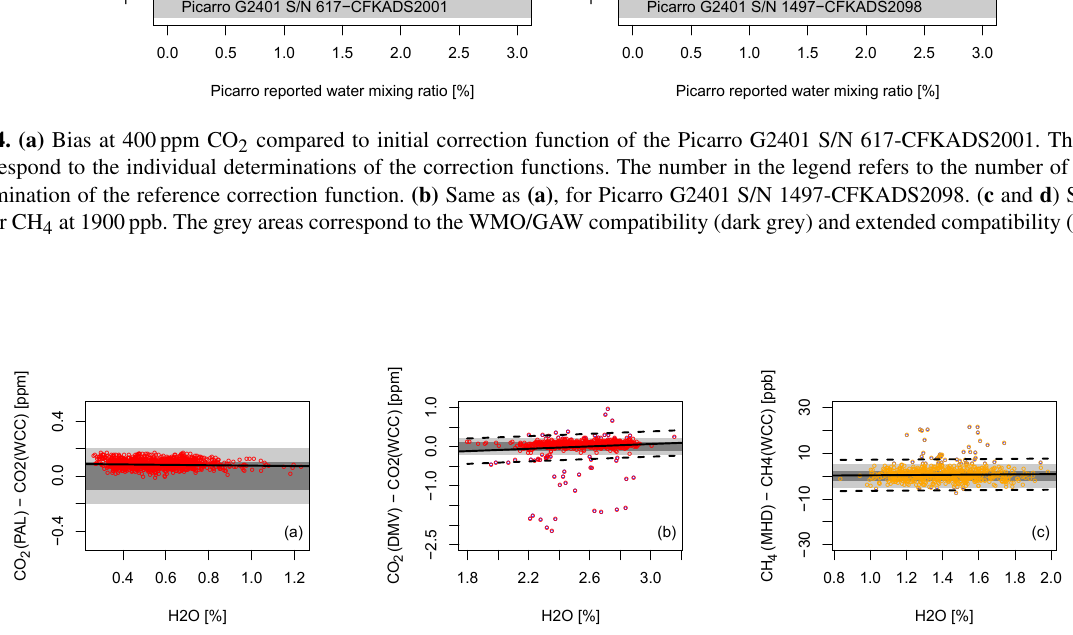
Figure 15. (a) CO 2 bias of PAL vs. H 2 O measured by the travelling instrument based on hourly matched data. The solid black lines denote the linear regressions, while the dashed lines are the 95% confidence bands. (b) Same as (a) , for DMV. (c) Same as (a) , for CH 4 at MHD. The grey areas correspond to the WMO/GAW compatibility and extended compatibility